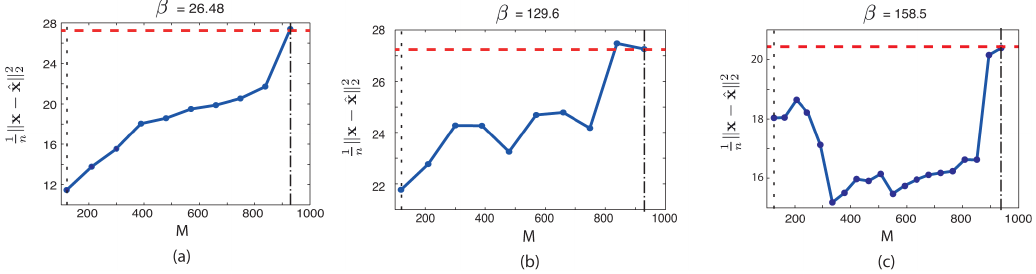
Figure 7. Performance of TRANSAC combined with Tikhonov regularization. In the three plots, the red dashed line indicates the estimation error given by typical Tikhonov (Eq. 2). The dashed line on the right indicates M = m , the one on the left indicates M = n . Plot (a) shows the results of the sanity check. As the selected number of measurements M increases, the MSE of the estimation decreases. Notice that the maximum MSE corresponds with M = m . Plot (b) shows the results of applying TRANSAC to the ETEX data set without critical measurements. Again, the MSE increases in general with M, and the maximum MSE appears in M = m . Plot (c) shows the results of applying TRANSAC to the whole ETEX data set, critical measurements included. In this case, the MSE does not always increase with M , but the maximum MSE still corresponds with M = m .